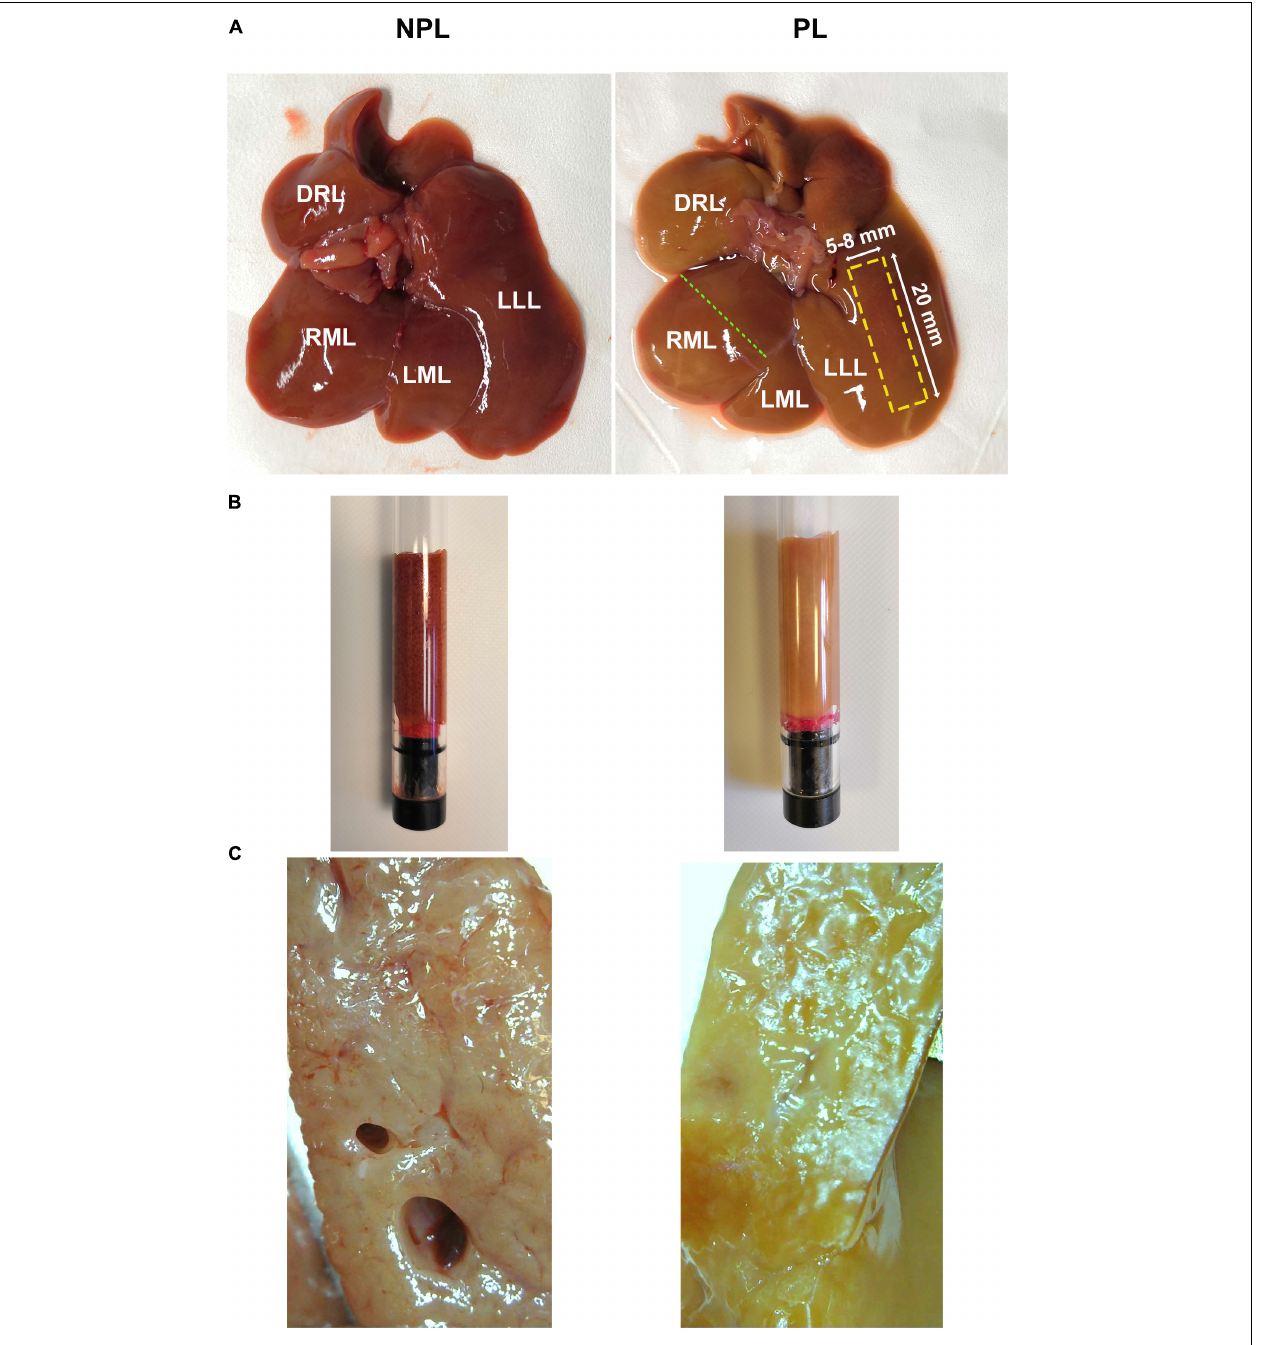
FIGURE 1 | (A) Photograph of fresh non-perfused livers (NPLs, left) and perfused livers (PLs, right); a rectangular area marked by a dashed yellow line indicates the site from which the sample for MRI was taken. The green dashed line indicates the position of the cross-sectional area shown in (C) . (B) Sample tubes containing liver tissue obtained from NPL and PL for DWI and MRE. (C) cross-sectional area of the liver showing more blood in the NPL sample (left) than in the PL sample (right). NPL, non-perfused liver; PL, perfused liver; LLL, left lateral lobe; LML, left middle lobe; RML, right middle lobe; DRL, dorsal right lobe.